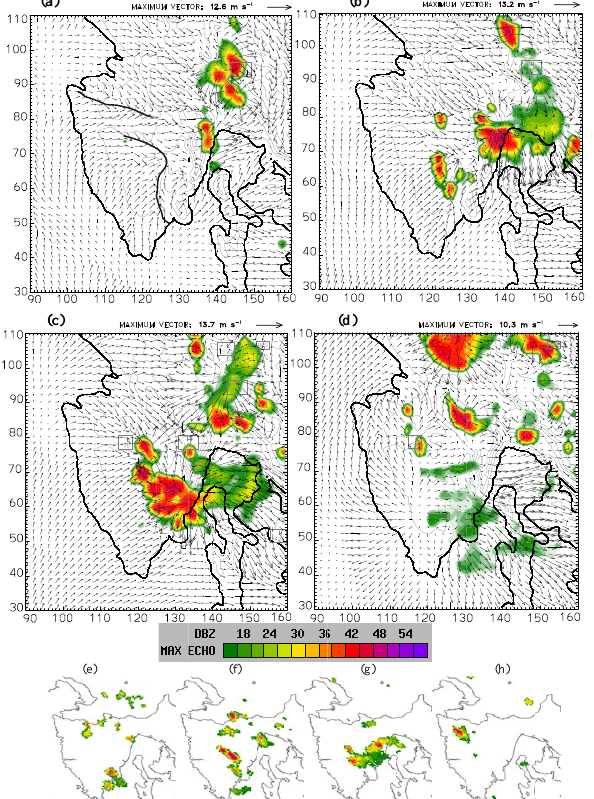
Fig. 7. (a – d) Diurnal evolution of the modelled near-surface wind (in ms − 1 , at 10ma.g.l.) associated with the maximum simulated equivalent radar reflectivity factor (dBZ) on 8 August 2006 at (a) 12:00CET, (b) 13:00CET, (c) 14:00CET and (d) 16:00CET. Wind vectors are depicted in every second grid point (reference length in the upper right corner-hand corner). The thick black solid line in (a) indicates the position of the main convergence zone. (e – h) Radar reflectivity factor (dBZ) in radar images (source: ARSO – www.meteo.si) on 8 August 2006 at (e) 11:10CET, (f) 13:00CET, (g) 13:50CET and (h) at 15:30CET. The radar reflectivity is given with a 3dBZ interval.